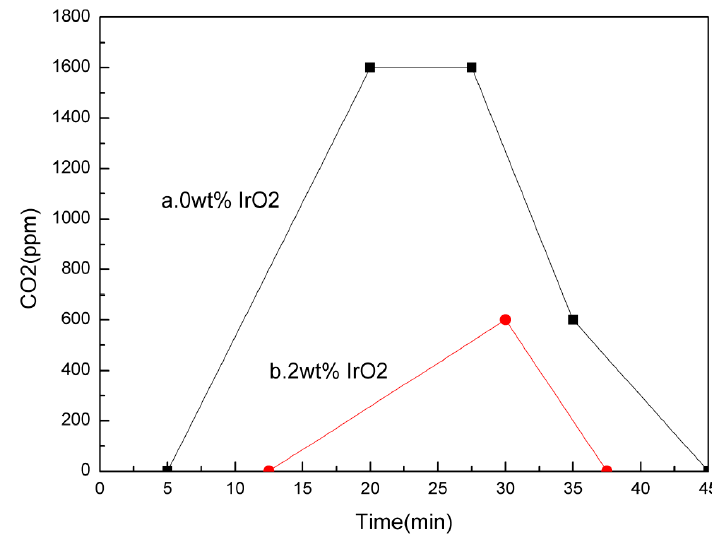
Figure 7. MEA–CO 2 mass spectrum ( a ) without IrO 2 ; ( b ) with 2 wt % IrO 2 . Reproduced with permission from [67]. Copyright American Chemical Society, 2010.